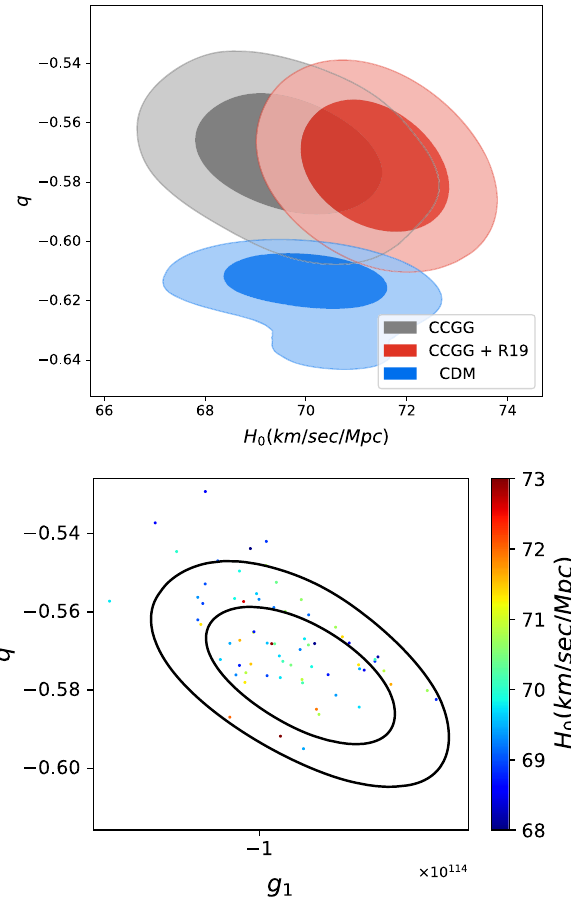
Fig. 4 One- (68% CI) and two-dimensional (68% and 95% CI) marginalized posterior distributions for the the deceleration parameter q vs. the Hubble parameter H 0 . The gray contour describes the CCGG best fit with a uniform prior. The red contour describes the CCGG best fit with the SH0ES measurement as a prior. Finally, the blue contour describes the (cid:2) CDM best fit with a uniform prior. The lower panel shows a 3D of q and the parameter g 1 vs. the Hubble parameter H 0